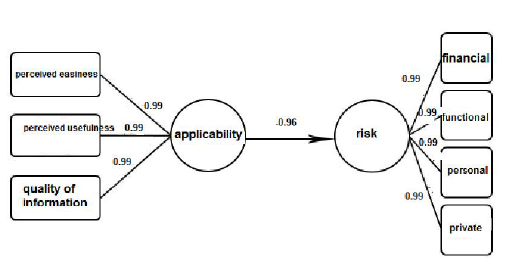
Fig. 4. The results of testing the second hypothesis